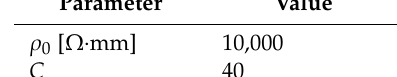
Table 3. Parameters of the continuum resistivity model.